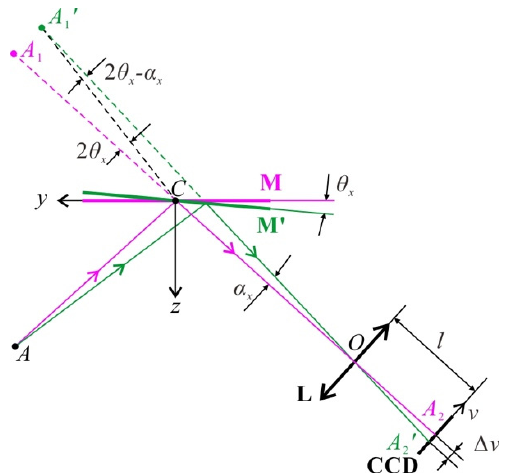
Figure 3. Imaging geometry for measuring the rotation angle θ x of mirror element M from the image displacement Δ v . A is the object point. M rotates around its center C by an angle θ x to M' . A 1 and A ' 1 are the virtual images of A by mirror M and M' , respectively. L is the objective lens and O is its optical center. A 2 and A ' 2 are the images of A 1 and A ' 1 on the CCD sensor. The displacement between A 2 and A ' 2 is Δ v .